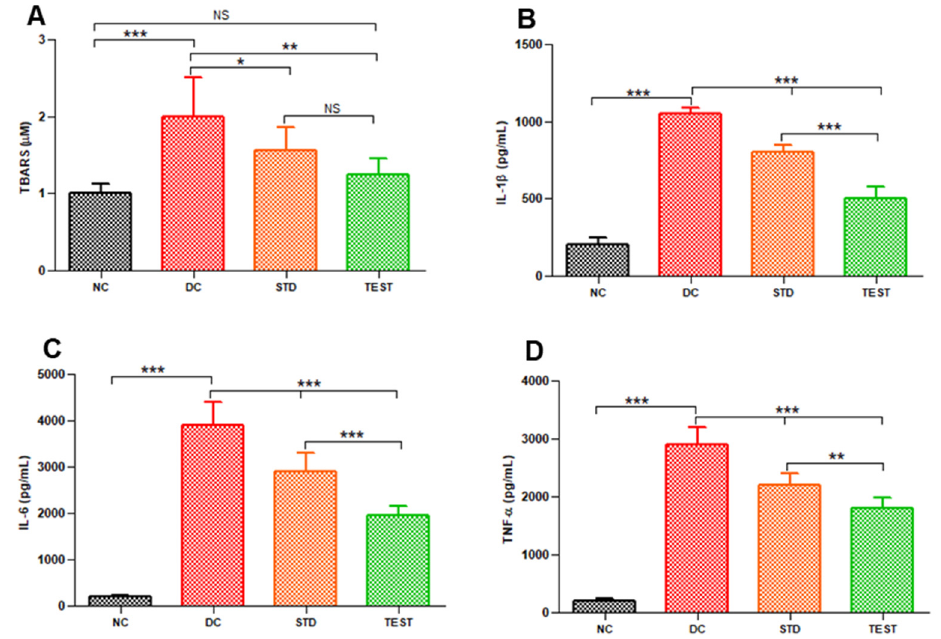
Figure 5. Levels of lipid peroxidation and various inflammatory markers in BALF from various groups namely, Normal Control (NC), Disease Control (DC), standard treatment with conventional dexamethasone injection (STD) and test formulation treatment with dexamethasone microspheres (TEST) ( n = 6) ( A ) TBARS, ( B ) IL-1 β , ( C ) IL-6, and ( D ) TNF- α . *, **, and *** represents significant difference at p < 0.05 and p < 0.01 and p < 0.001, respectively, by Newman–Keuls analysis following ANOVA at 95% confidence limit. NS = Not significant.